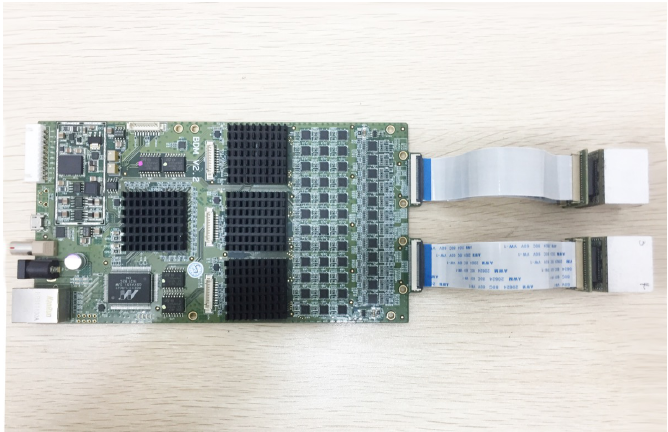
Figure 2. The P&I sensor system. Two P&I modules are connected to a MVT readout